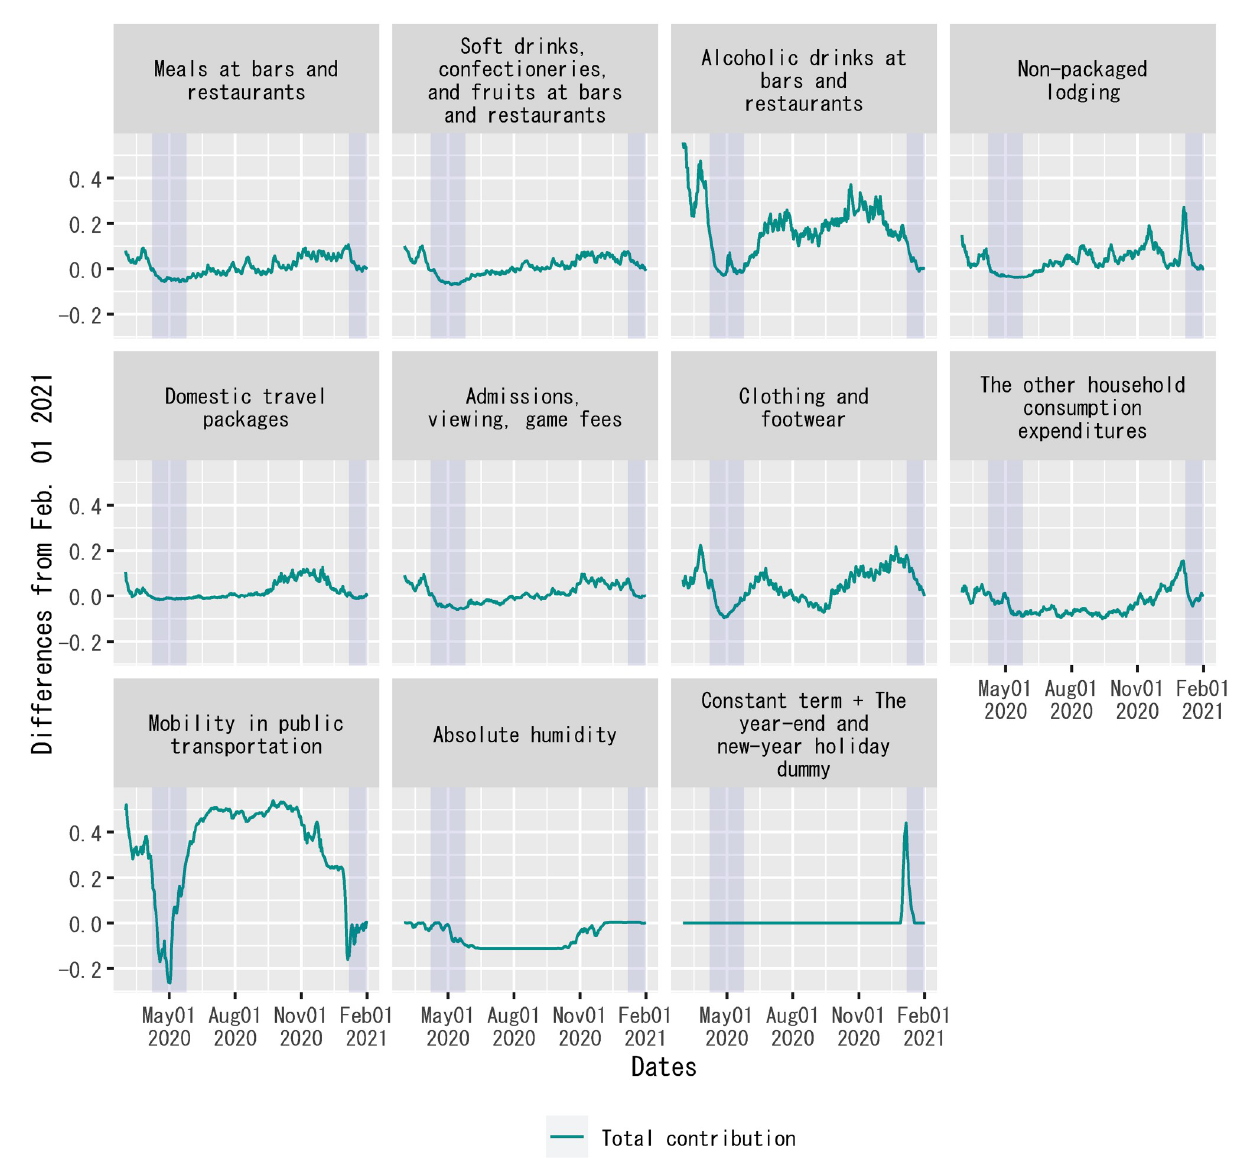
Fig 10. Decomposition of fitted values of the regression: Differences from a benchmark date. Each panel shows the differences in the product of an explanatory variable and the posterior mean of the corresponding regression coefficient from February 1, 2021, when time dummies for the period before the first state of emergency, the first state of emergency, and the second state of emergency are set to zero without changing the posterior means of regression coefficients. The sample period shown in the figure is from March 1, 2020, to February 1, 2021. For household expenditures and mobility in public transportation, “Total contribution” indicates differences in the posterior mean of γ j F ( X j , t ) + θ j F ( D AH , t X j , t ) in Eq (7) on each date from February 1, 2021. Each shadowed period indicates a state of emergency.